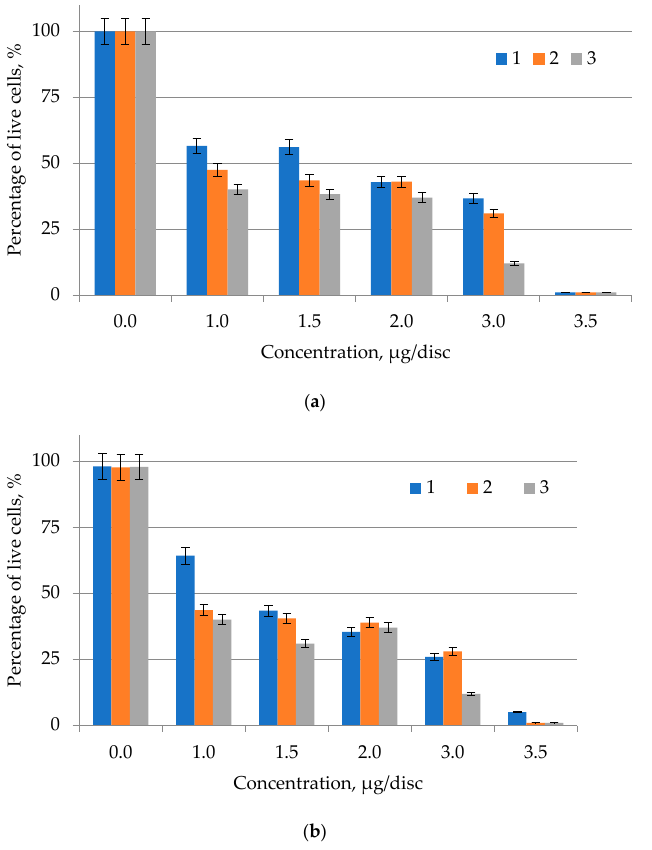
Figure 4. Dependence of the minimum inhibitory concentration (MIC) of the purified lipid–pigment complex and the inhibition level (IL) ( a )— С . vulgaris; ( b )— A. platensis; 1— E. coli ; 2— B. pumilus; 3— L. mesenteroides .